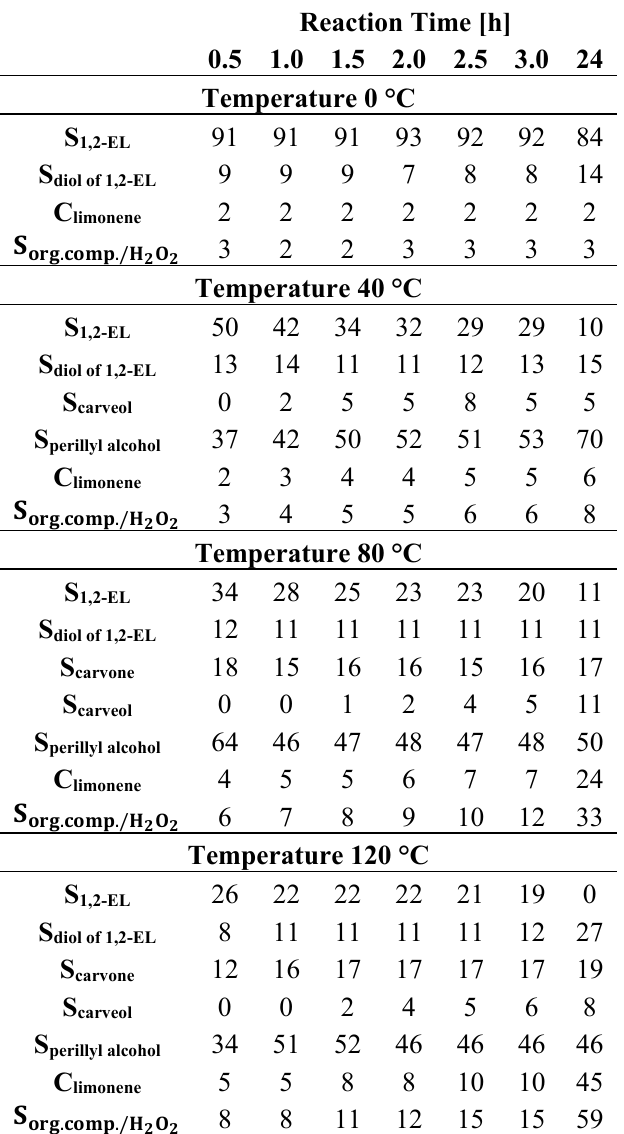
Table 1. Studies on the influence of the temperature and the reaction time on the course of limonene epoxidation over the TS-1